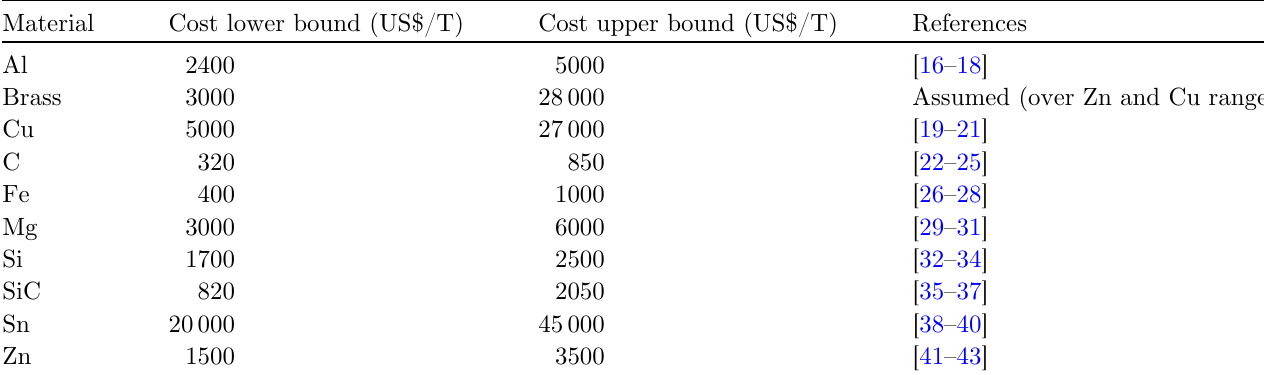
Table 1. Material cost bounds used in economic analysis.